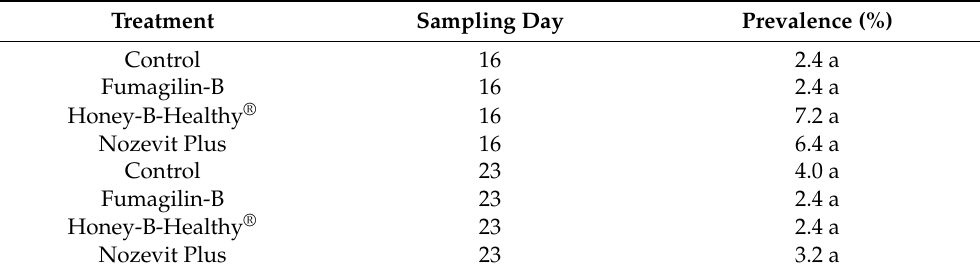
Table 1. Experiment 1: Prevalence (percent of infected individuals) of Vairimorpha spp. in honey bees provided various treatments. The sampling occurred on two days (16 and 23) post treatment. Prevalence means with different letters are significantly different at α ≤